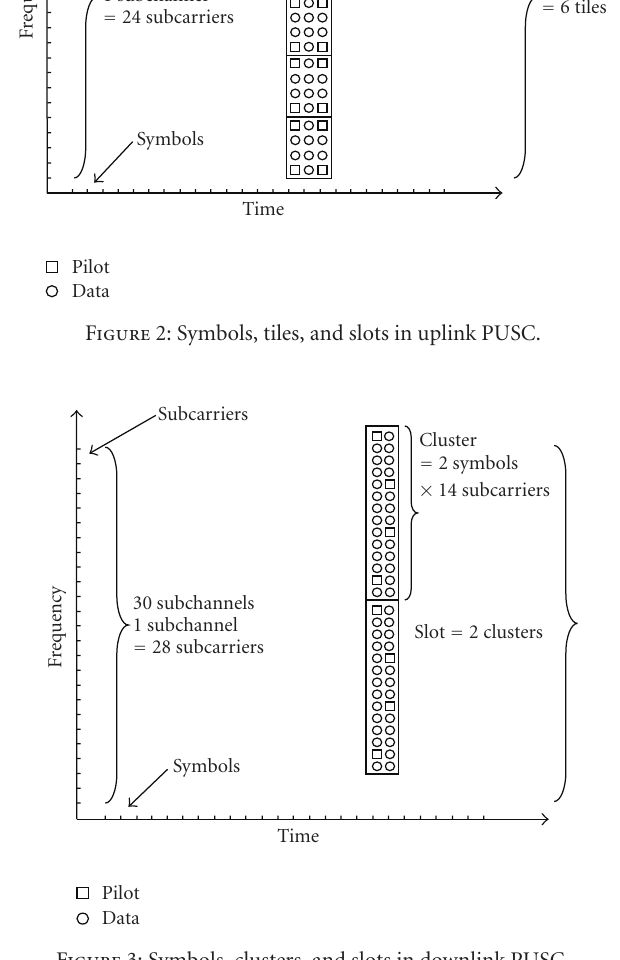
Figure 3: Symbols, clusters, and slots in downlink